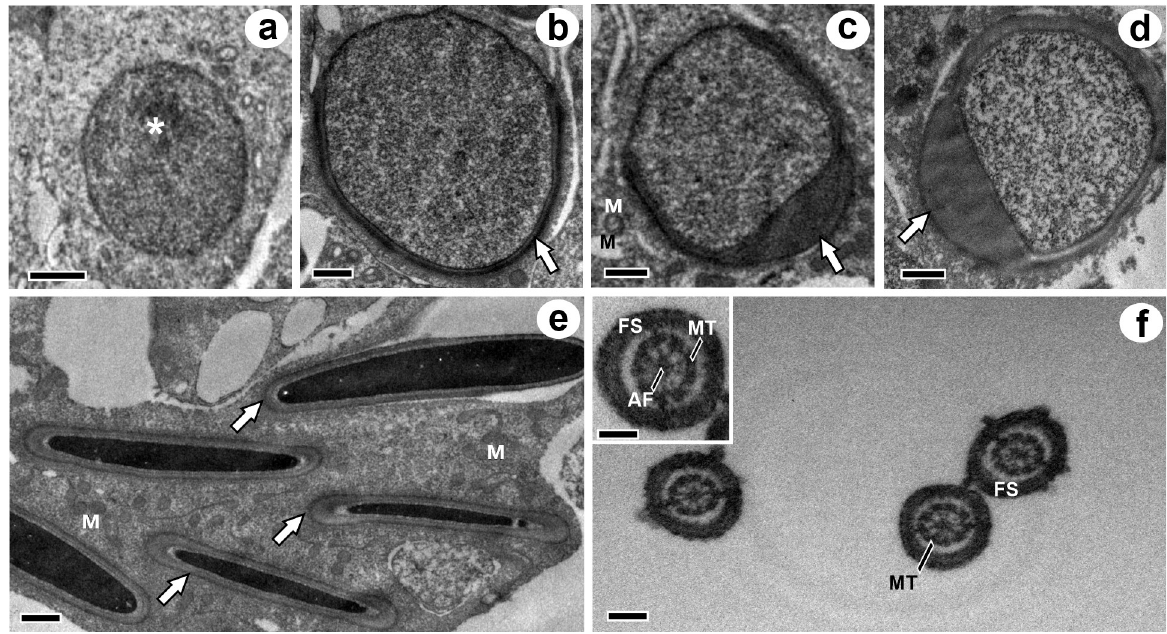
Fig 4. Ultrastructural aspects of spermiogenesis of Diphylla ecaudata . a: round spermatid without acrosomal cap, at stage 5 of seminiferous epithelium cycle; b-d: spermatid elongation with different degrees of nuclear association of the acrosomal cap; e: elongated spermatids with complete formation of the acrosome cap; f: transverse sections of the flagellum. � : nucleoli; White arrow: acrosome; M: mitochondria; FS: fibrous sheath; AF: axial filament; MT: microtubule. Scale bars: a: 2 μ m, b: 0.5 μ m, c: 1 μ m, d: 0.2 μ m, e: 0.5 μ m, f: 0.2 μ m, detail: 0.2 μ m.